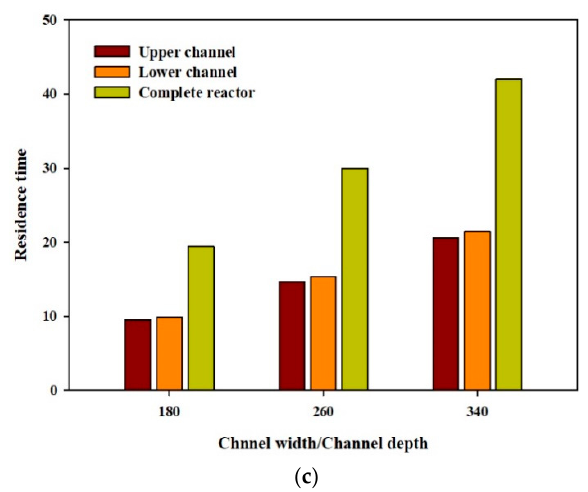
Figure 4. ( a ) Effect of mass flow rate on residence time at a water depth of 5.6 mm and slope angle of 1°. ( b ) Residence time for various water depths at a mass flow rate of 2.4 kg/s and slope angle of 1°. ( c ) Residence time for different channel width/channel depth ratios at a mass flow rate of 2.4 kg/s, water depth of 5.6 mm, and slope angle of 1°.